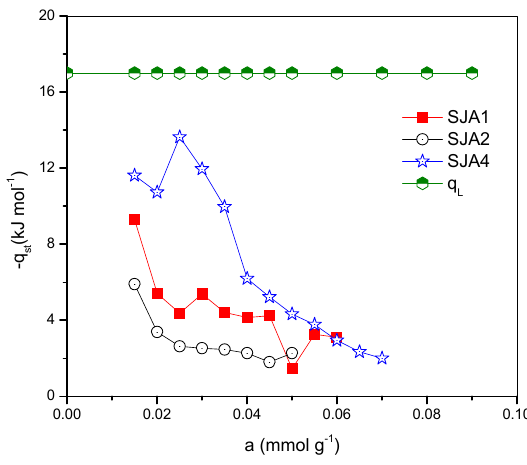
Figure 6. Isoteric heat of CO 2 adsorption of soil samples.